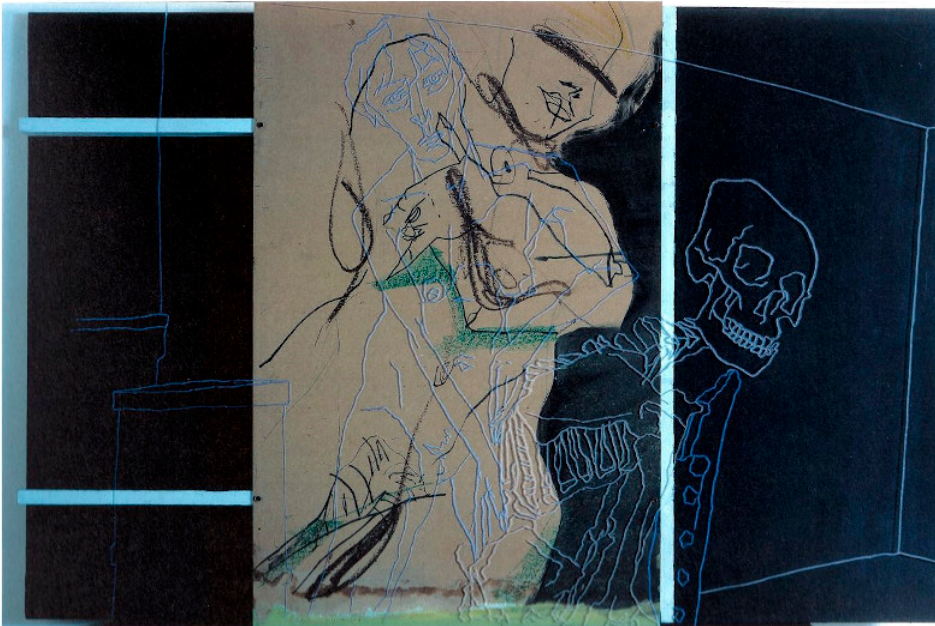
Figure 11. Anne-Mie van Kerckhoven, Violence & The Sacred: Way of the Cross and Crucifixion, 1995, felt pen on paper, plexiglass on wood, 101 × 155 × 6.5 cm.